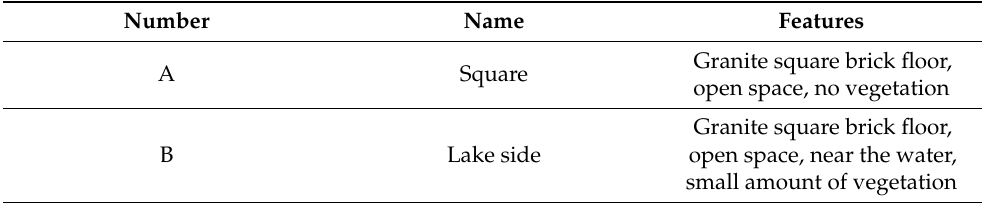
Table 1. Features of outdoor physical spaces at each